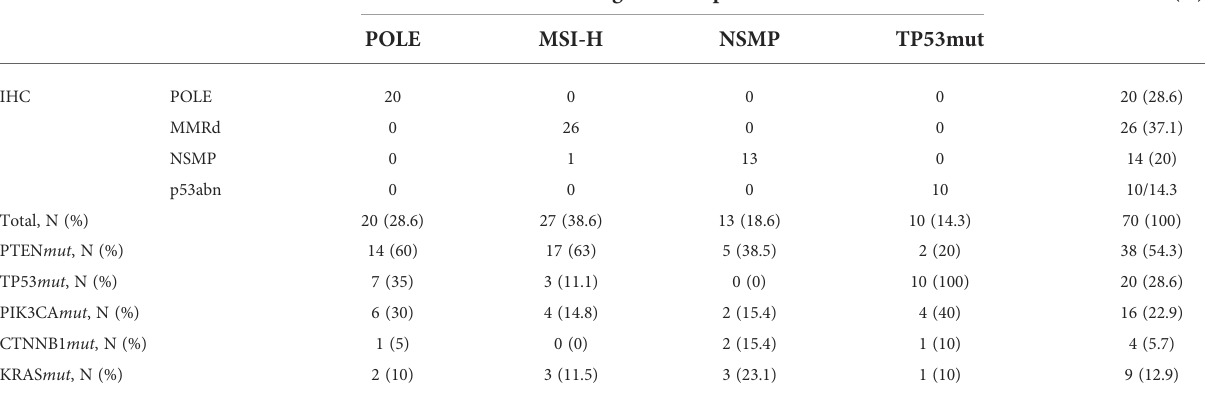
TABLE 2 Molecular classi fi cation of 70 G3 EECs.